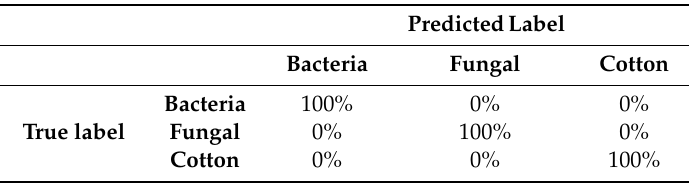
Table 2. Confusion matrix of the GBA classification model using the ACS training data grouped into broad classes. The proportion of the model predicted labels (columns) are compared to the true label (rows) for each broad training class and presented as a percentage value.